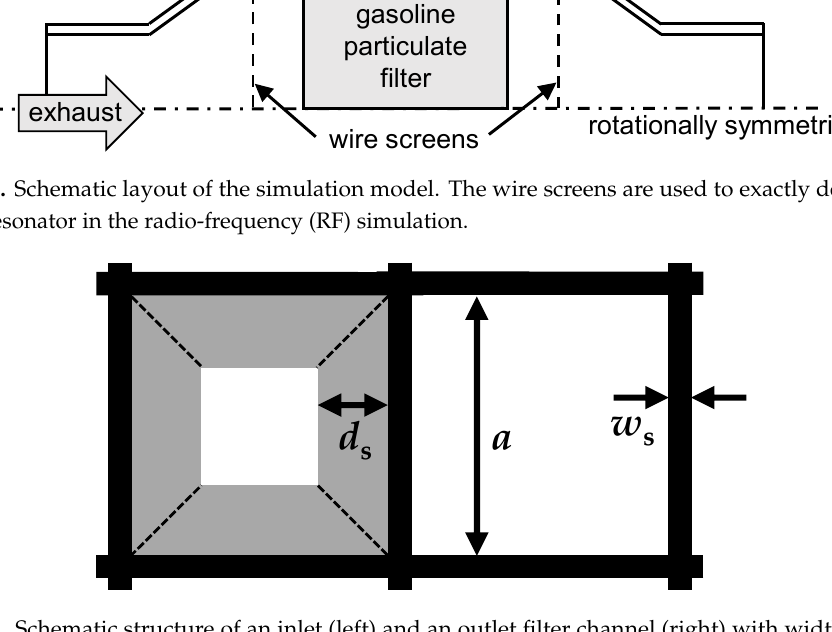
Figure 2. Schematic structure of an inlet (left) and an outlet filter channel (right) with width a , wall thickness w s , and soot cake thickness in the inlet channel d s (adapted from Konstandopoulos et al. [32]).